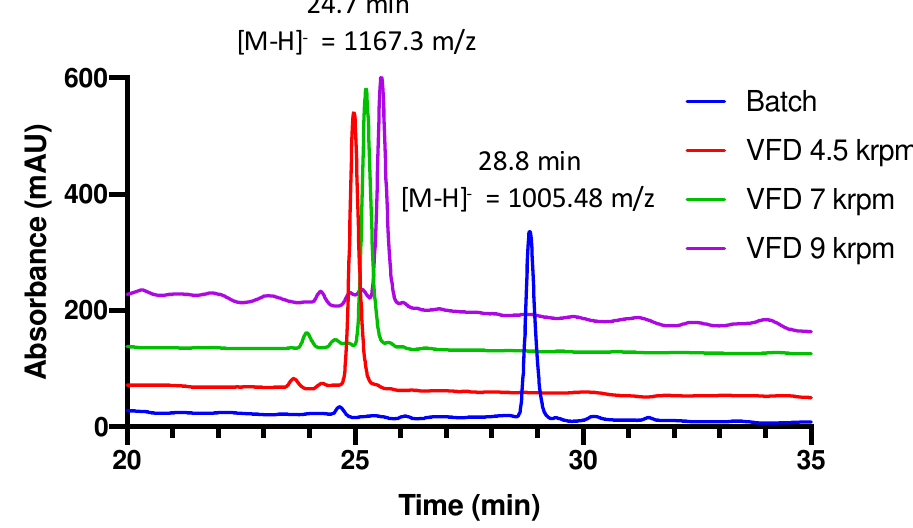
Figure 5. Overlays of HPLC traces of the oxytocin reaction products at pH 10. Peaks at 24.7 min correspond to the S-sulfonated product and peak at 28.8 min corresponds to oxytocin.